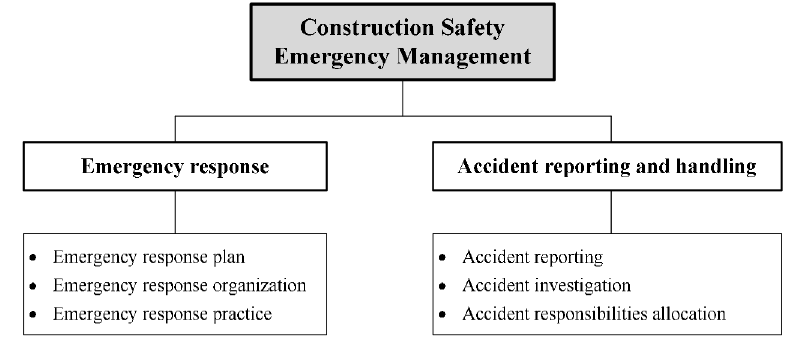
Figure 7. Structure of the safety emergency management subsystem